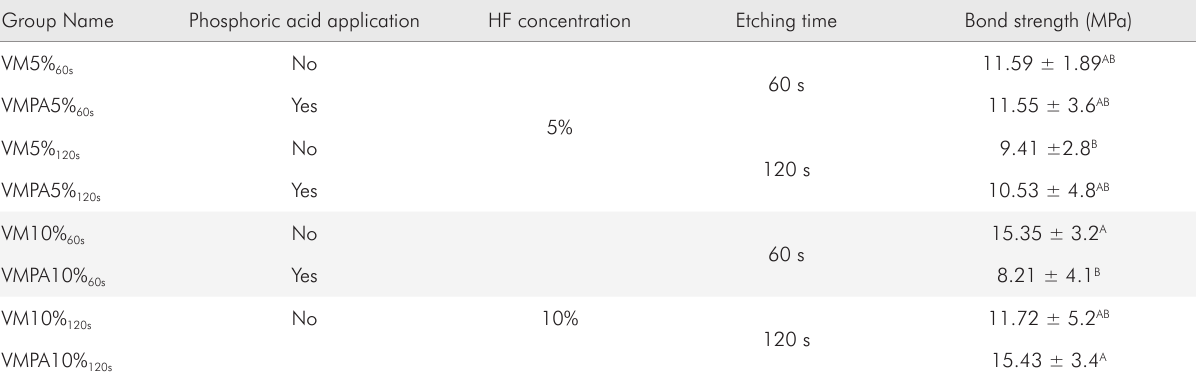
Table 3. Bond strength of groups according to the factors “Phosphoric acid”, “HF Concentration” and “Etching Time”. Data are reported as means (MPa) and standard